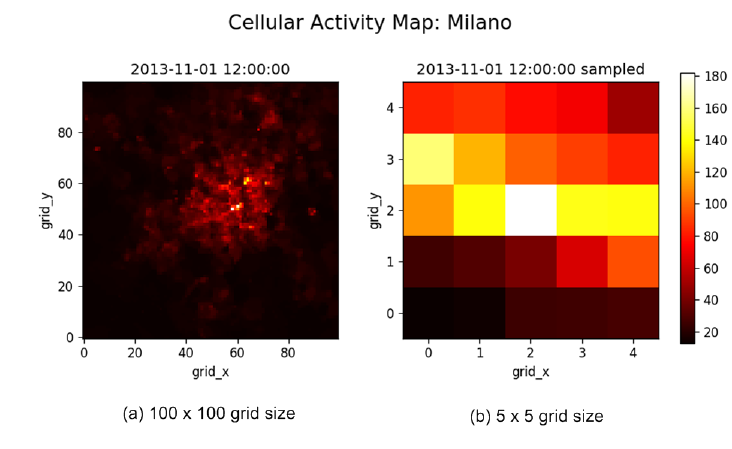
Figure 5. Spatial variaton of CDR activity over Milan at a specific time instant.